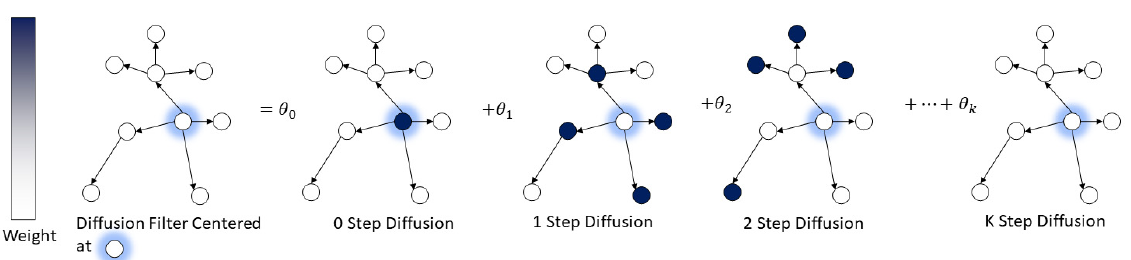
Figure 2. Illustration of the diffusion convolution process with K diffusion steps.